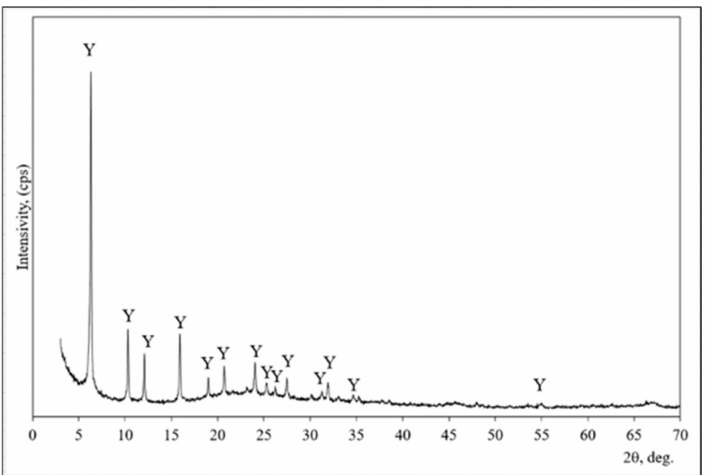
Figure 1. The X-ray diffraction pattern of zeolitic by-product. Note: Y is faujasite (73-2312) H 7.7 Al 42.56 · Si 139 · O 345.6 .